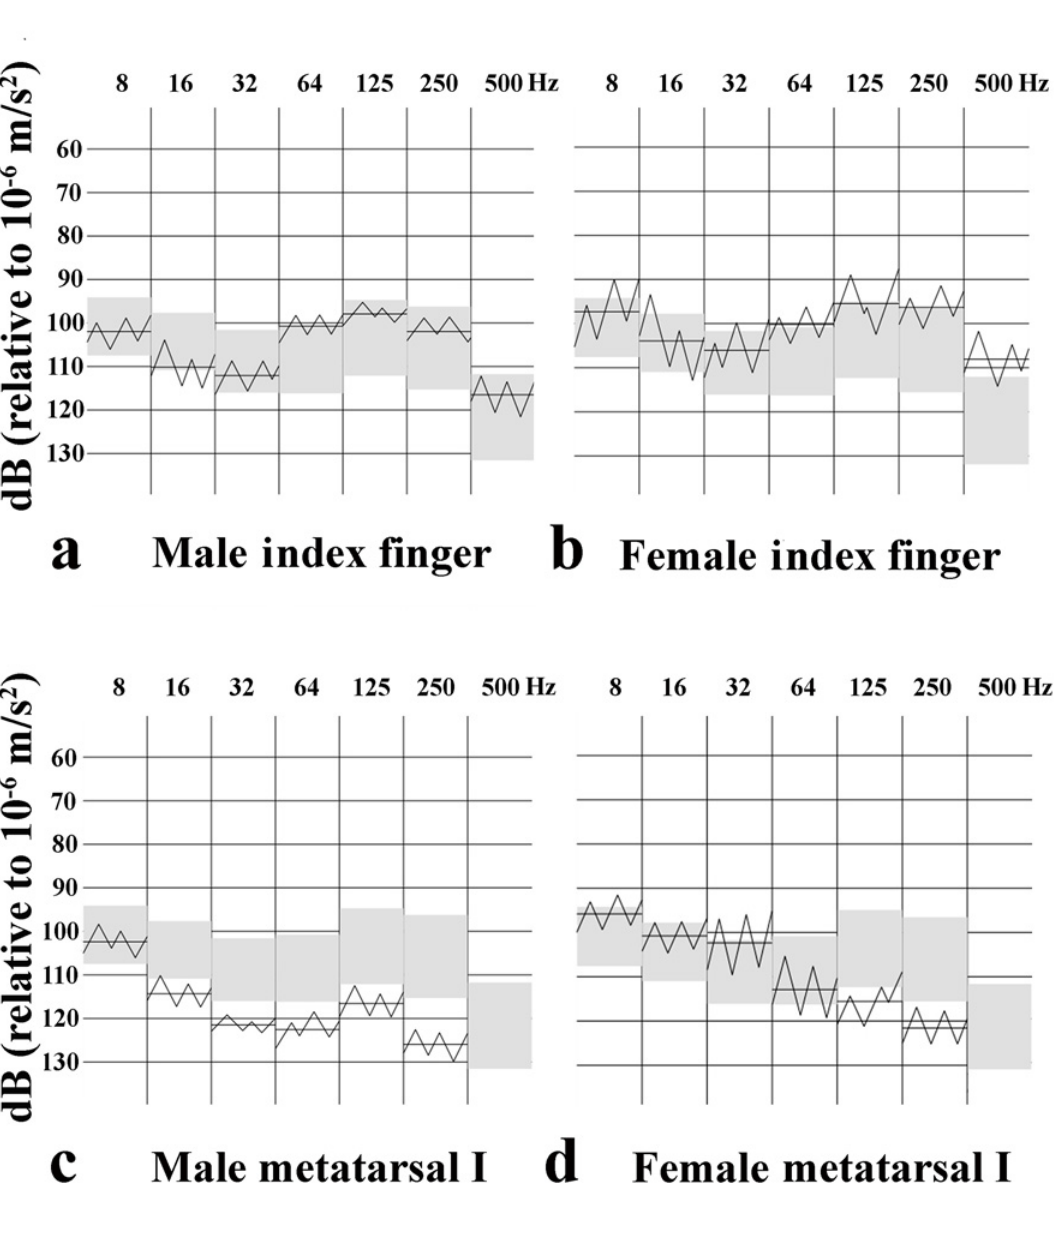
Fig 2. Tactilogram with vibrotactile perception thresholds. Vibrotactile perception thresholds (VPTs) at different frequencies from a male (A, C) and female (B, D) in the index finger (A, B) and at the first metatarsal (metatarsal I) head in the sole of the foot (C, D). The grey area corresponds to normative age mapped VPTs values (mean ± 1 SD) for healthy